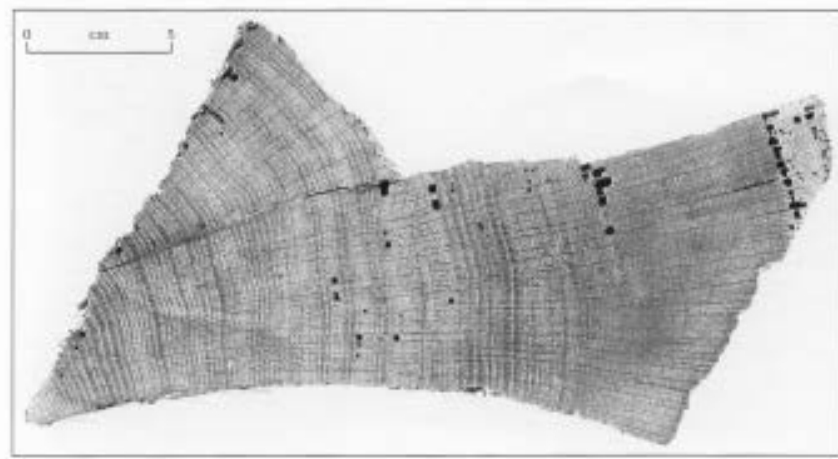
Figure 2 A cross-section of oak showing the variable widths of the growth rings. The lighter rings in the outer (right-hand) 2 cm are sap wood rings. The black holes (2-3 mm in diameter) are the result of destruction by deathwatch beetle, usually more common in the sapwood, but here found also in the inner heartwood.